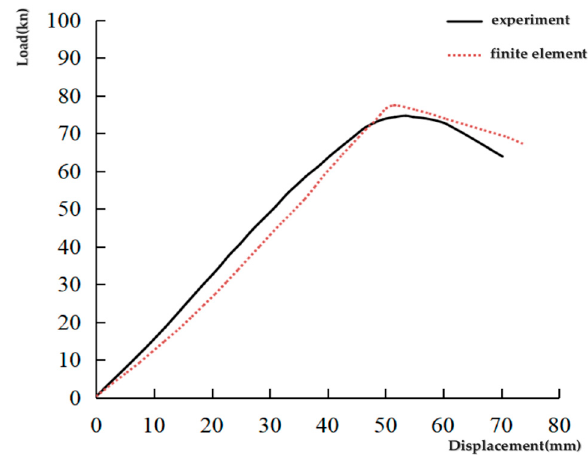
Figure 6. Comparison of JD-3 load-displacement curves.